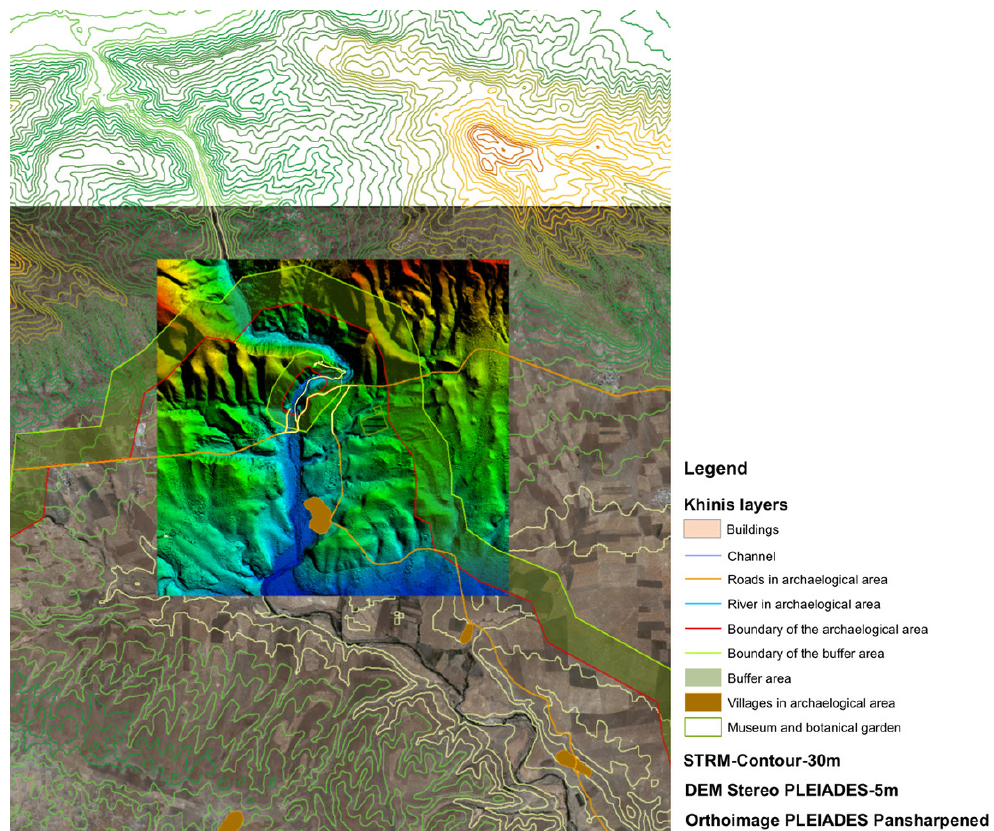
Figure 12. Topographic/archaeological layers have been stored inside a GIS environment. The management of different layers with different information are fundamental for the planning process of the area. The legend shows the different layers represented in the